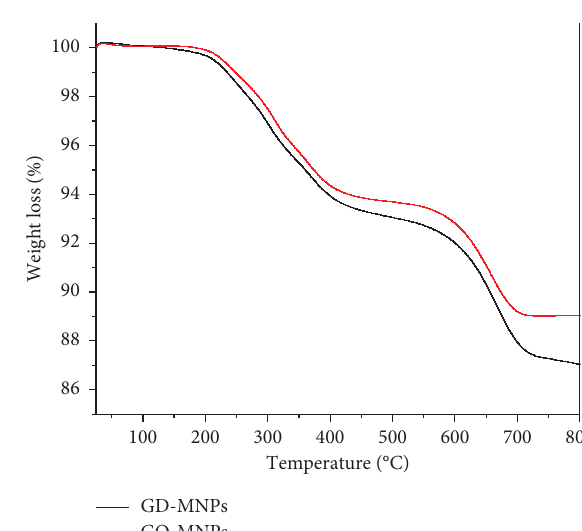
Figure 3: XRD pattern of GD-MNPs and GO-MNPs.